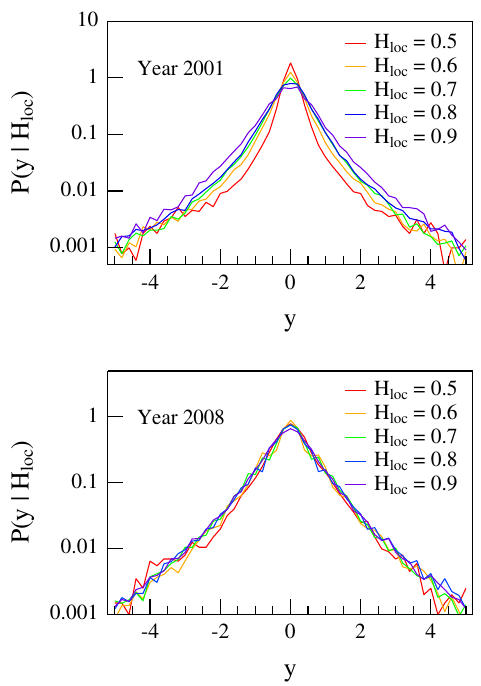
avalanching nature of magnetospheric dynamics (Consolini and Chang, 2001; Chang et al., 2003) during periods char- acterized by the occurrence of geomagnetic substorms and